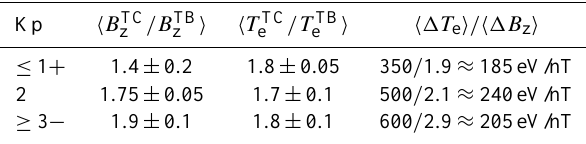
Table 1. Ratios of electron temperature and magnetic field. Num- bers of events for three Kp range are 42, 43, and